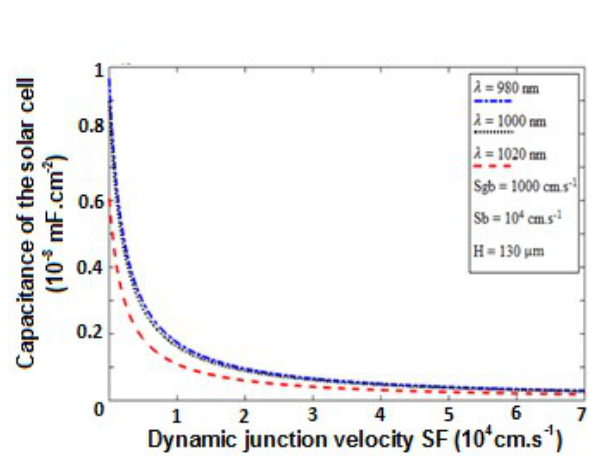
Figure 4. Capacitance of the illuminated solar cell versus SF for various wavelength: L = 0.01 cm and R= 0.01